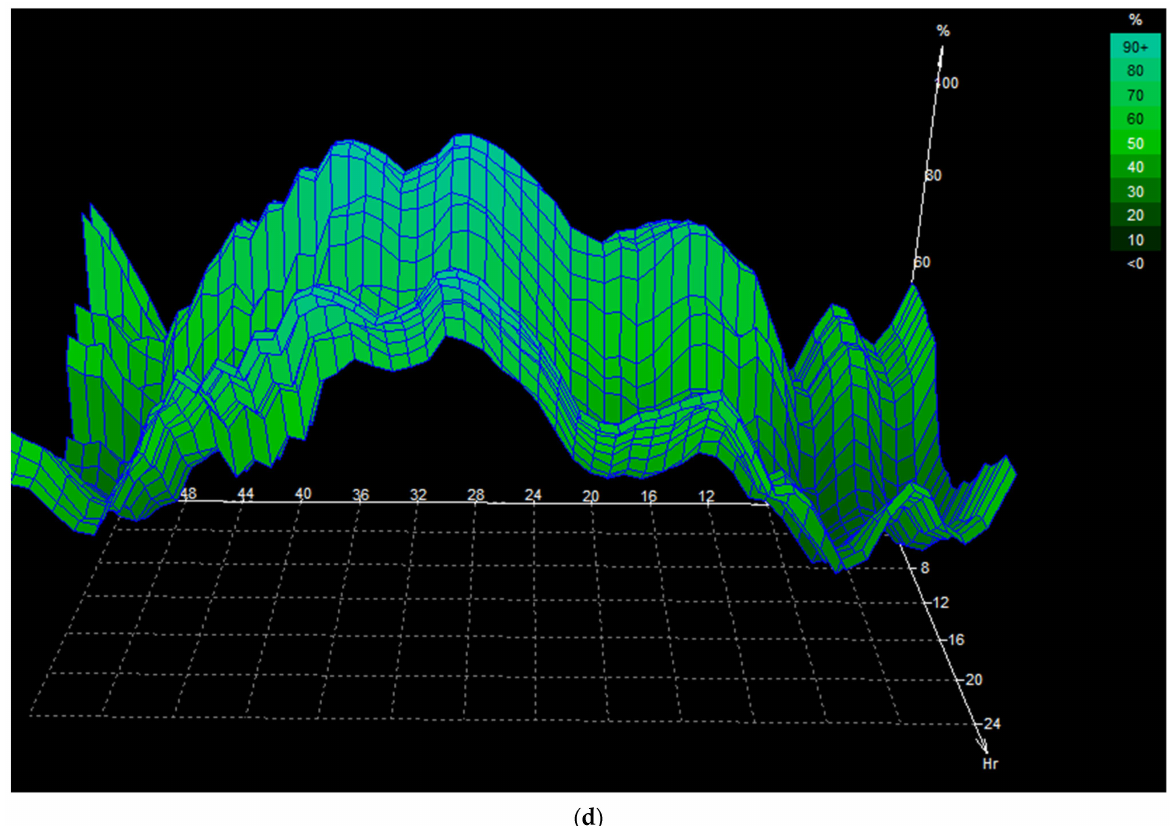
Figure 23. ( a ) Monthly temperature chart; ( b ) three-dimensional temperature map; ( c ) monthly humidity chart; ( d ) three-dimensional humidity diagram.